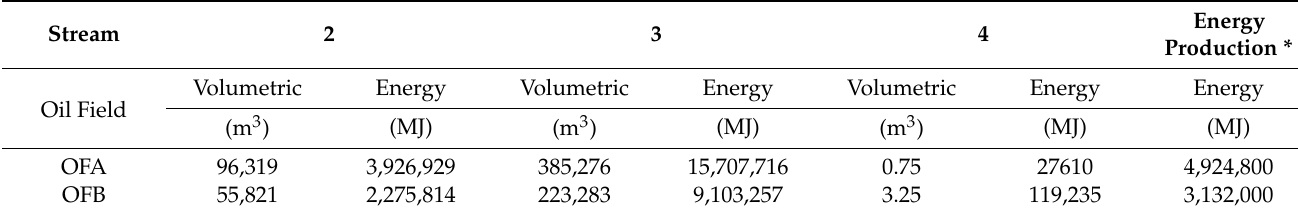
Table 4. Input sources for energy production from non-renewable resources.